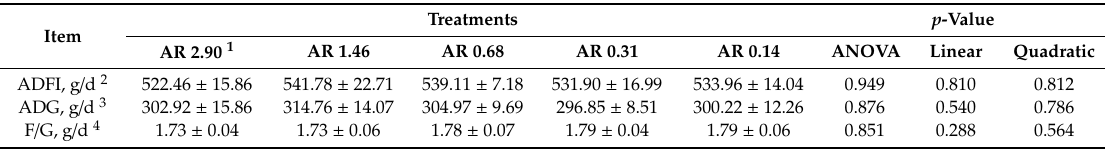
Table 4. E ff ects of dietary starch structure on the growth performance in weaned piglets (mean values with their standard